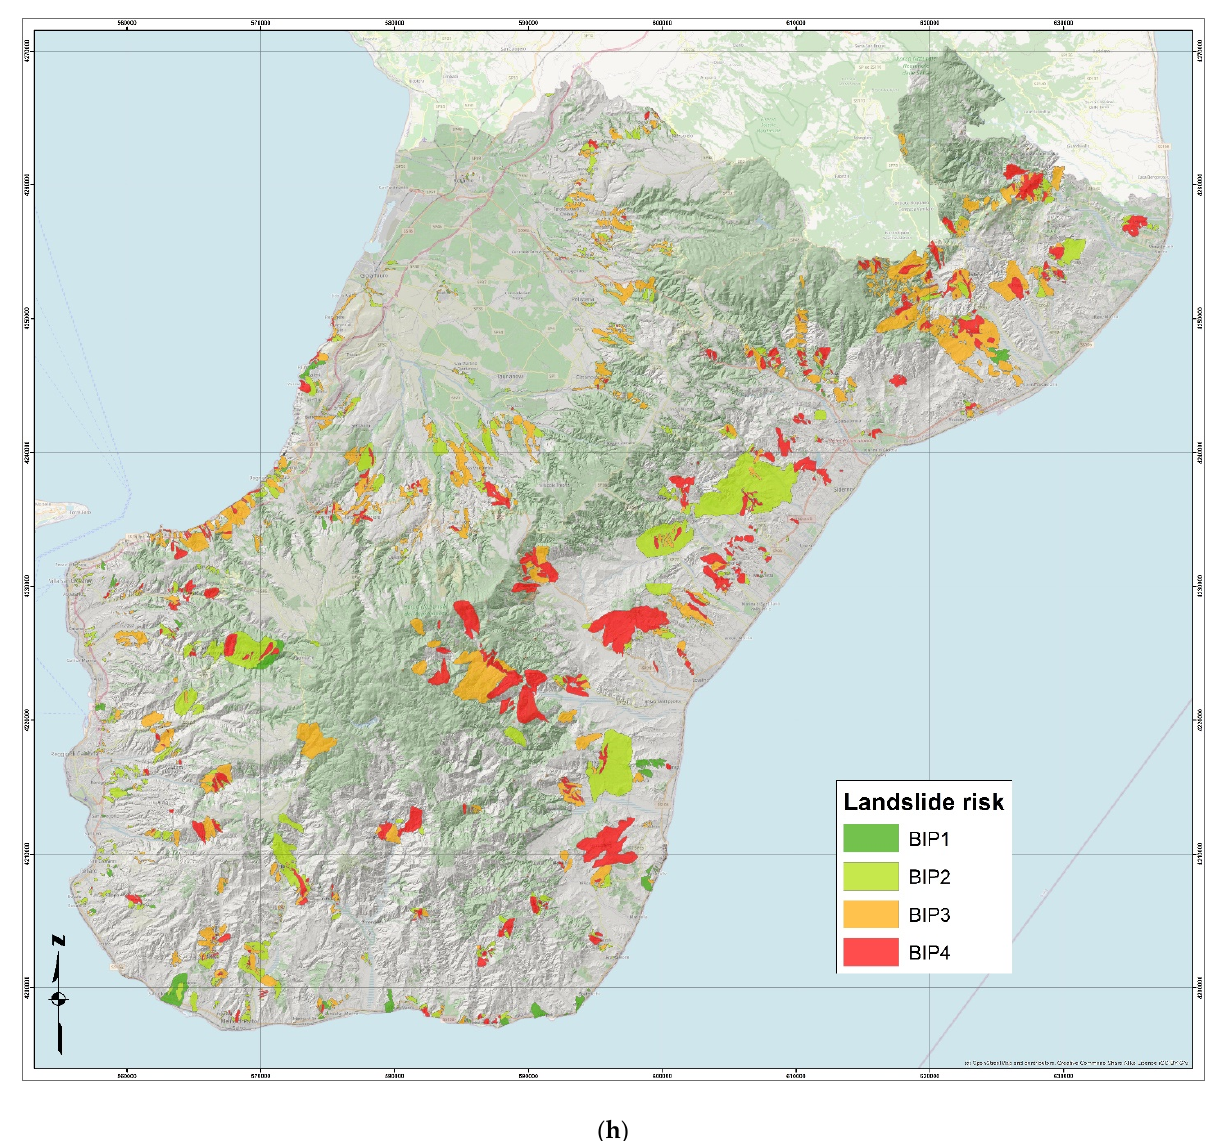
Figure 1. Topographical parameter maps: ( a ) slope degree; ( b ) land use; ( c ) elevation; ( d ) rainfall; ( e ) geology; ( f ) river distance; ( g ) road distance, ( h ) PAI landslide risk areas.